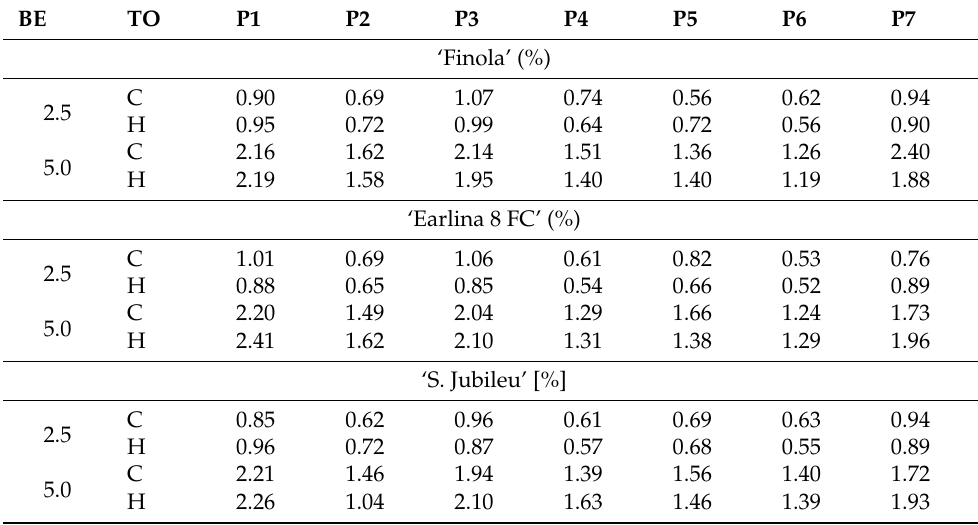
Table 4. The relative proportion of the amount of absorbed compounds from the oil. BE TO